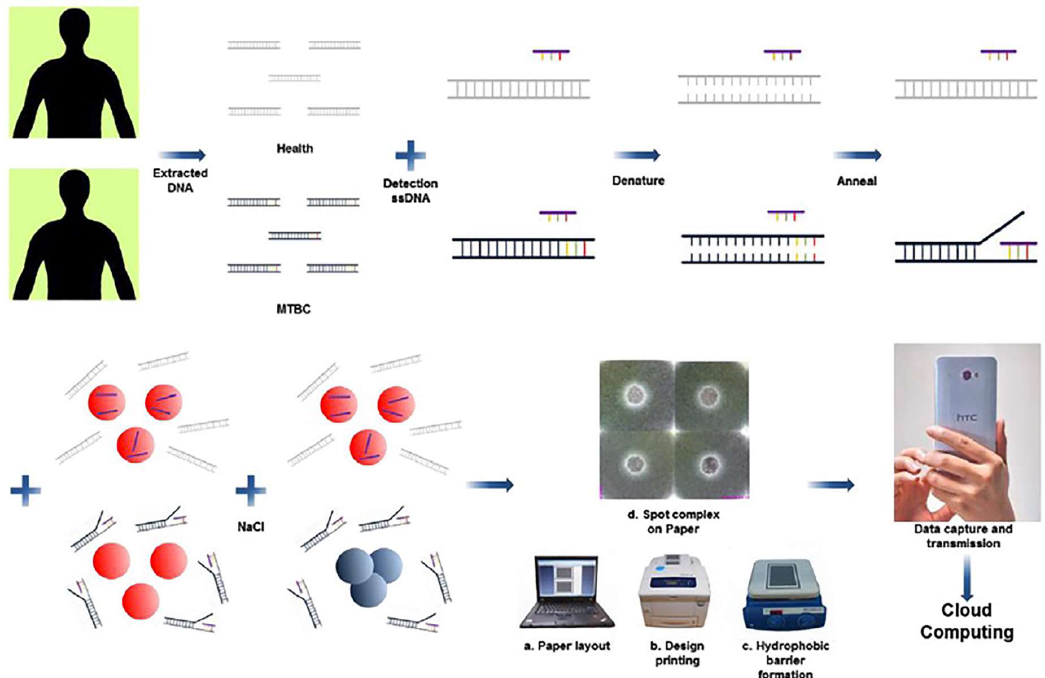
Figure 3. The mechanism of TB diagnosis using a paper-based sensor. If extracted DNA sequences contain IS6110 sequences (specific to Mycobacterium tuberculosis complex), detection oligonucleotide sequences will hybridize with the sequences. If IS6110 sequences are not present, the color of the mixture does not change, and stays red after hybridization with DNA. The color change can be quantified through the analysis of a picture taken via smartphone. Reproduced with permission from [61].